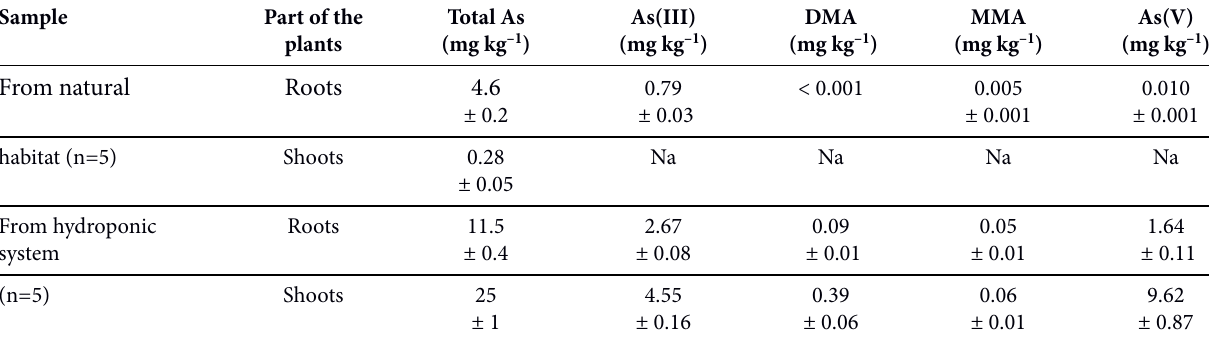
Table 2. Arsenic and its species in Eleocharis geniculata from its natural habitat and cultivated in a hydroponic system with the addition of As(V) Sample Part of the Total As As(III)